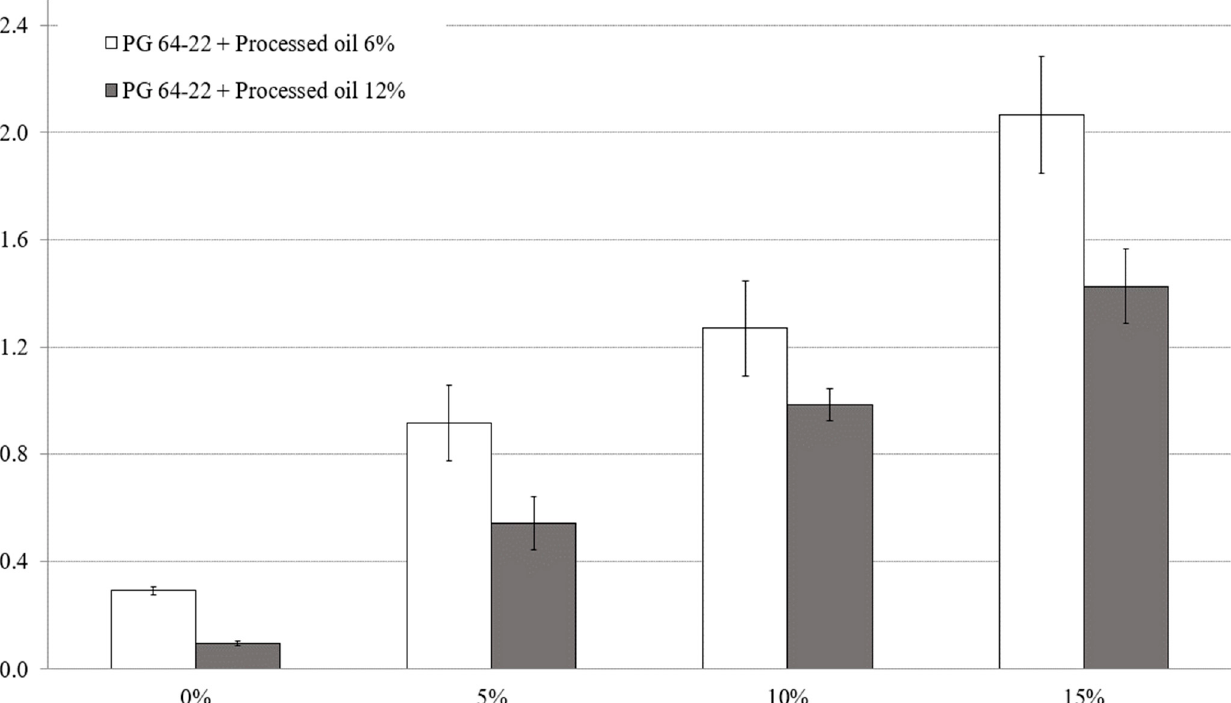
Figure 5. G*/sin δ value of short-term aged PG 64-22 binder modified with processed oil as a function of CRM content at 82 °C.